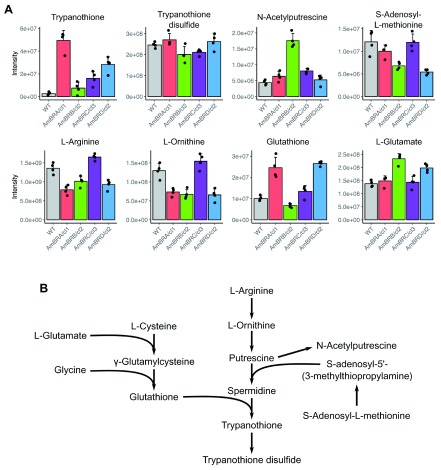
Changes in trypanothione biosynthesis.
A) Metabolite intensity plots for metabolites involved in trypanothione biosynthesis. Mean intensities across four biological replicates are shown, with error bars representing standard deviation. Black points represent intensities of individual replicates.
B) The trypanothione biosynthesis pathway.